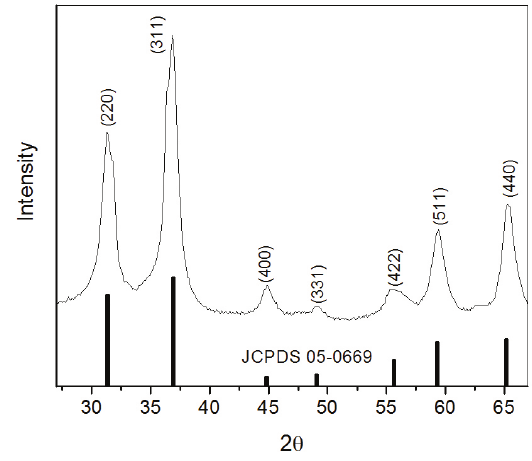
Figure 1. XRD pattern of ZnAl (JCPDS Card No. 05-0669) 31 .